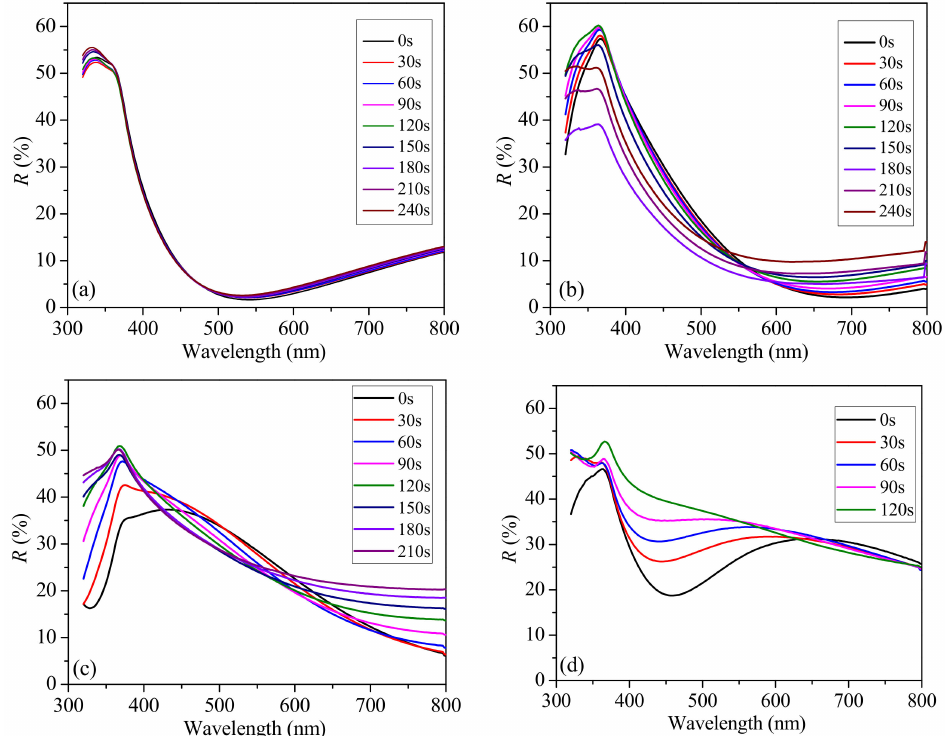
Figure 4. Reflectance spectra of hard-templated Nb 2 O 5 obtained by liquid-phase mixing of Nb sol and silica colloids in volume ratios of 50:1 ( a ), 20:1 ( b ), 10:1 ( c ) and 5:1 ( d ) during selective removal of SiO 2 phase by